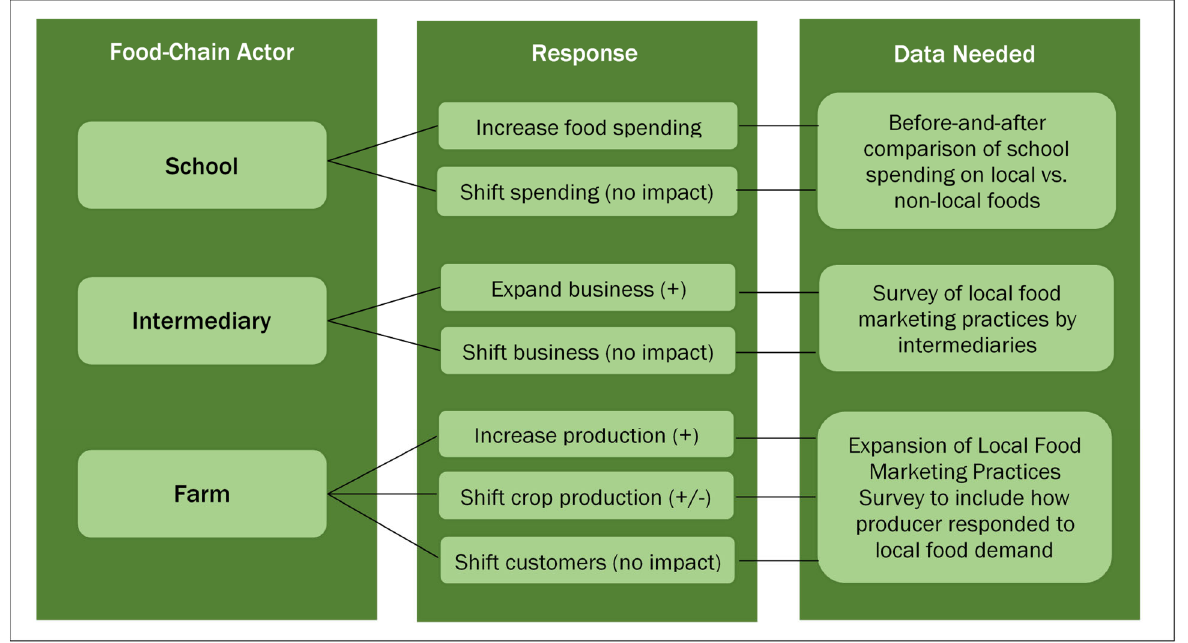
Figure 1. Farm-to-School Food-Chain Actors and Decisions that Influence Economic